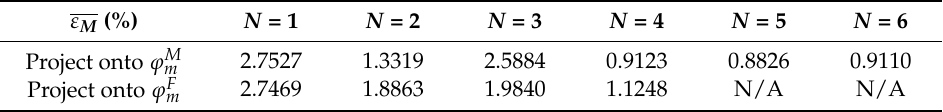
Table 3. Time-averaged error of matrix pressure for different projection